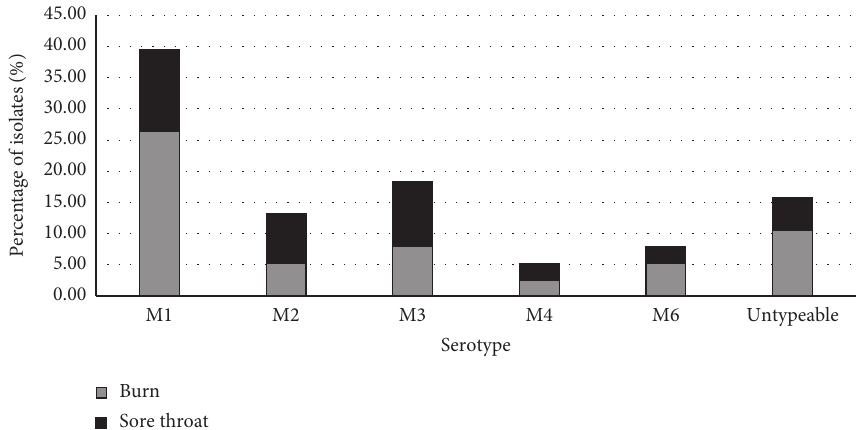
Figure 1: Prevalence of different serotypes among S. pyogenes isolates.